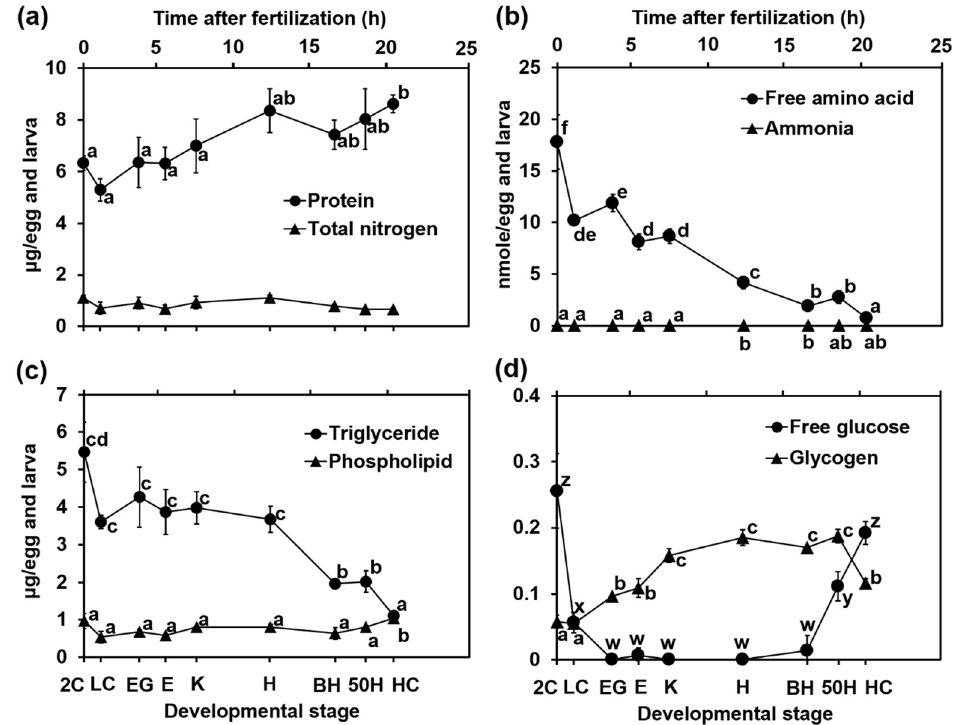
Figure 3. Changes in ( a ) protein and total nitrogen, ( b ) free amino acid and ammonia, ( c ) triglyceride and phospholipid, ( d ) free glucose and glycogen with the development of yellowfin tuna eggs and larvae. Values are presented as means ± SD. Letters next to values denote significant differences ( p < 0.05). Abbreviations are the same as those in Figure 2.